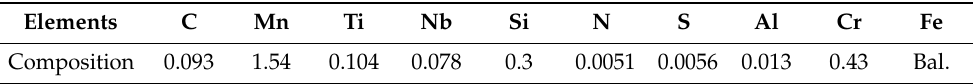
Table 1. Chemical composition of the examined steel (wt